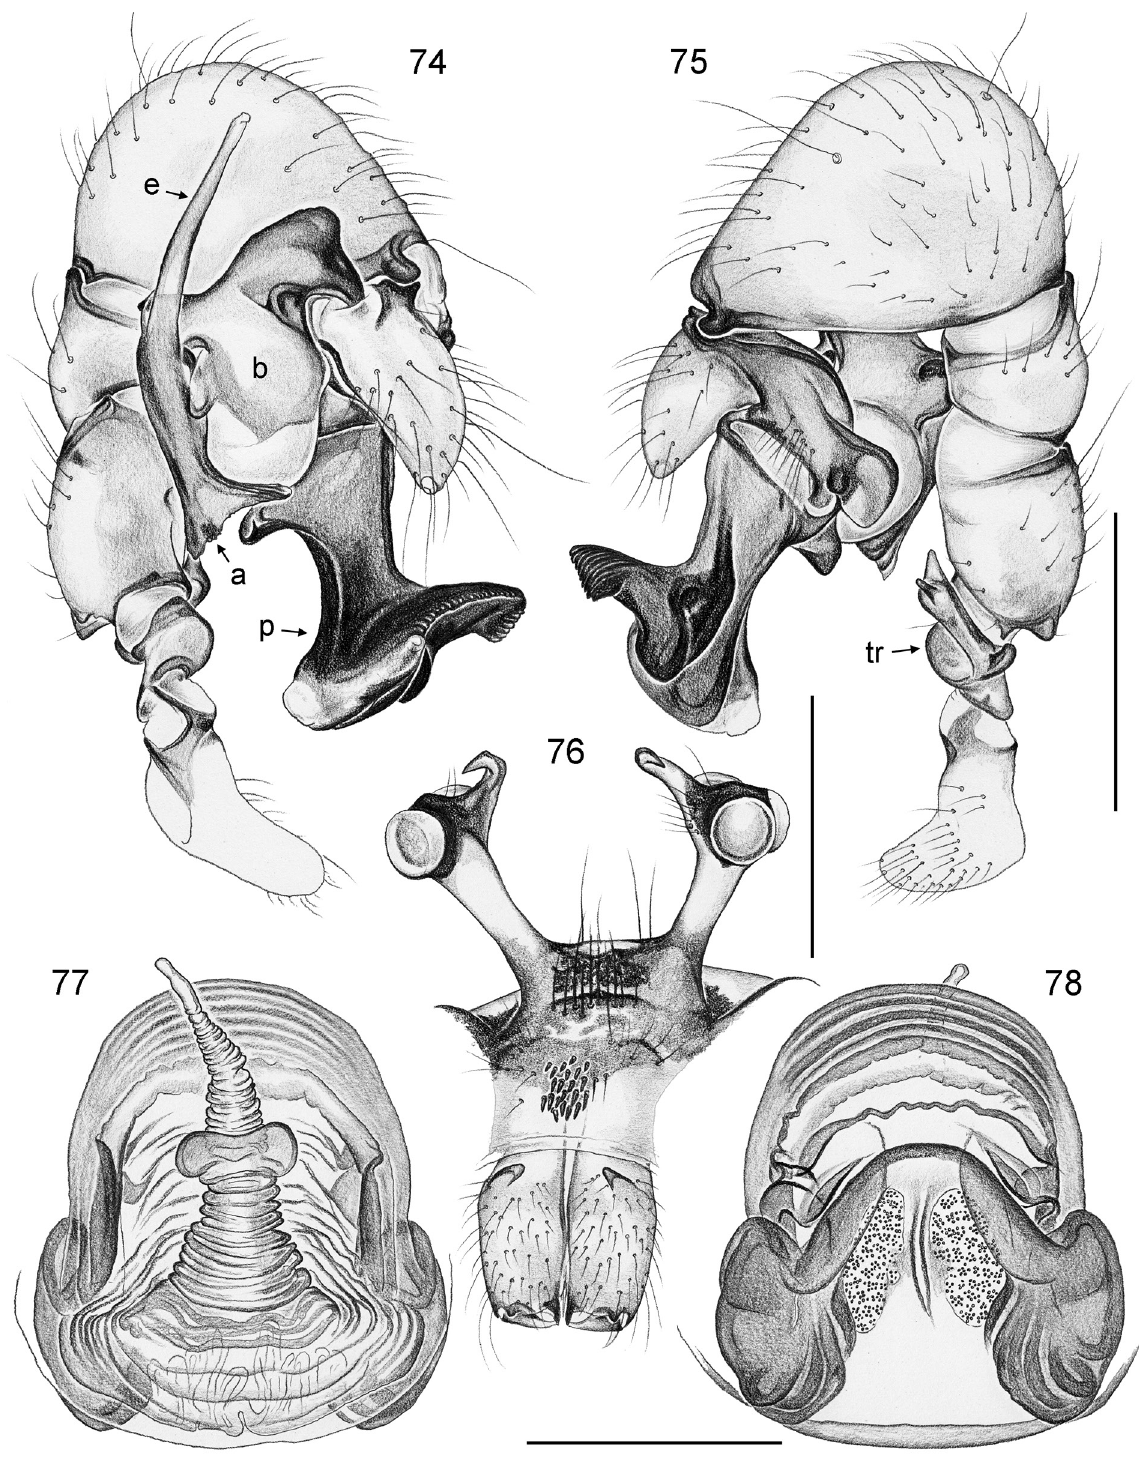
Figs 74–78. Panjange dinagat Huber sp. nov. (ZFMK, Ar 13016). 74–75 . Left male palp, prolateral and retrolateral views. 76 . Male prosoma and chelicerae, frontal view. 77–78 . Cleared female genitalia, ventral and dorsal views. Abbreviations: a = appendix; b = genital bulb; e = embolus; p = procursus; tr = trochanter. Scale bars: 74–76 = 0.5 mm; 77–78 = 0.3